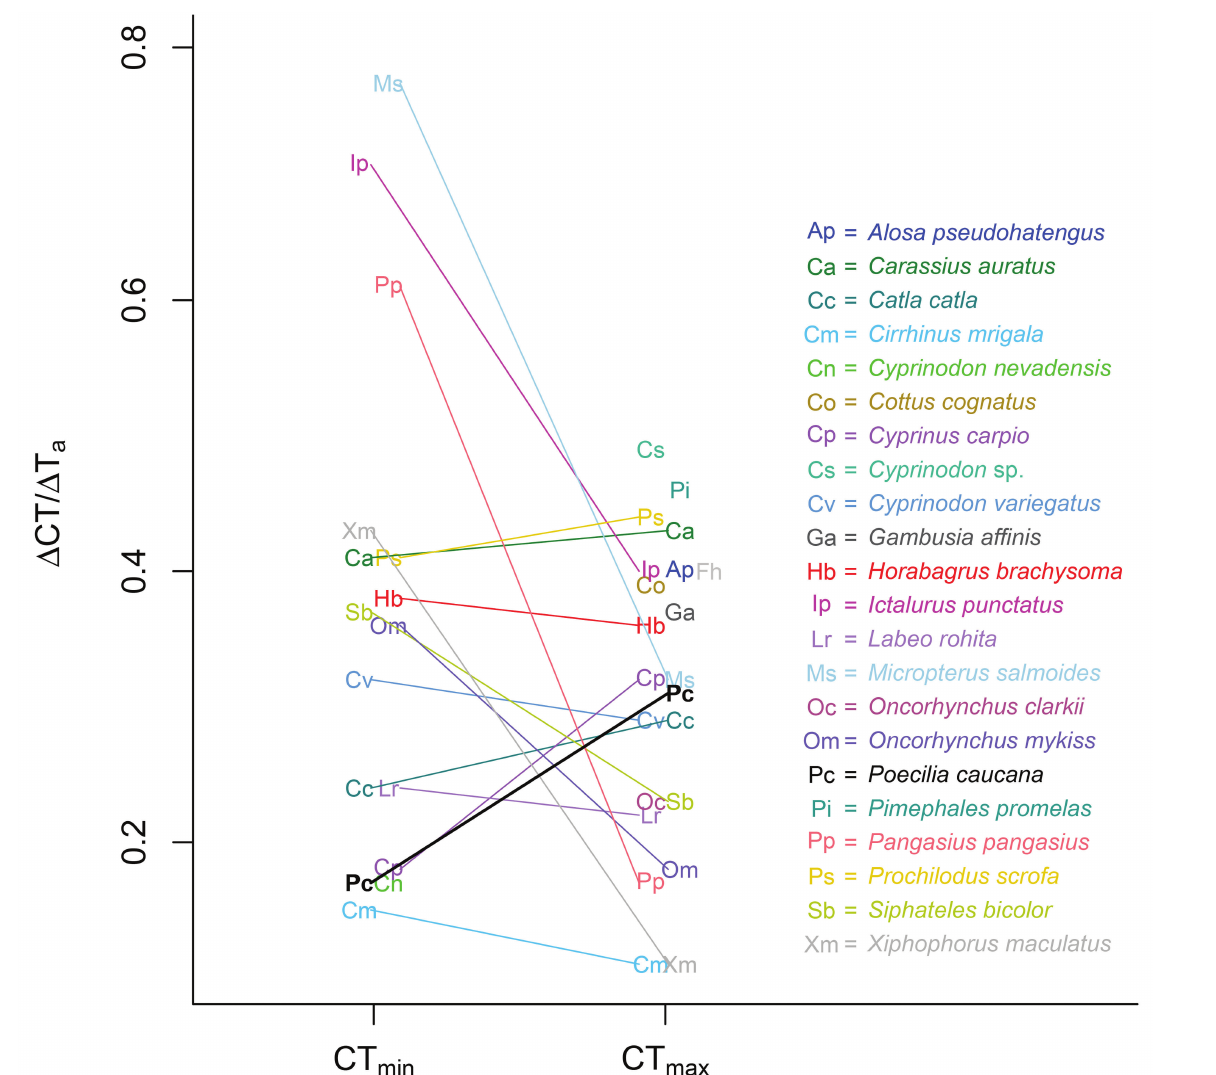
Fig. 3 . Comparison of acclimation capacity for Poecilia caucana (Pc, bold letter and thicker line) and a sample of species with CT and acclimation temperature values available in the literature. Lines join acclimation capacities for CT same species, when both values are available. Symbols are jittered in the horizontal axis to avoid crowding. Abbreviations as in Fig. 2 except for Ap = Alosa pseudoharengus (Otto et al. , 1976); Cn = Cyprinodon nevadensis (Feldmeth et al. , 1974); Cs = Cyprinodon sp. (Otto & Gerking, 1973); Fh = Fundulus heteroclitus (Bulger & Tremaine, 1985); Ga = Gambusia affinis (Otto, 1973, 1974); Oc = Oncorhynchus clarkii (Heath,